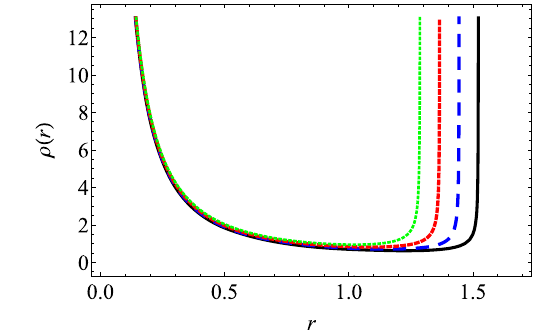
Fig. 2 Energy density for for C 1 = − 1, C 2 = 1 (cid:9) = 0 . 00 (black solid line), (cid:9) = 0 . 1 (dashed blue line), (cid:9) = 0 . 20 (short dashed red line) and (cid:9) = 0 . 30 (dotted green line). The other values have been taken as unity. See text for